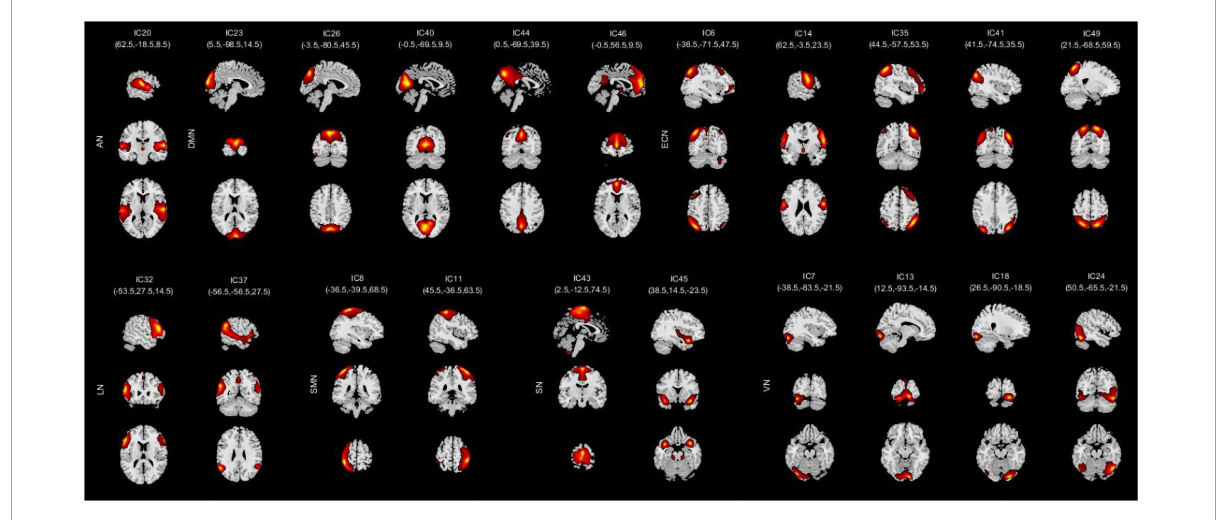
FIGURE1 Spatial independent component analysis (ICA) method was used to identify independent components ( n = 21). Divide the independent component spatial maps into seven functional networks according to their anatomical and functional properties, namely, AN, DMN, ECN,